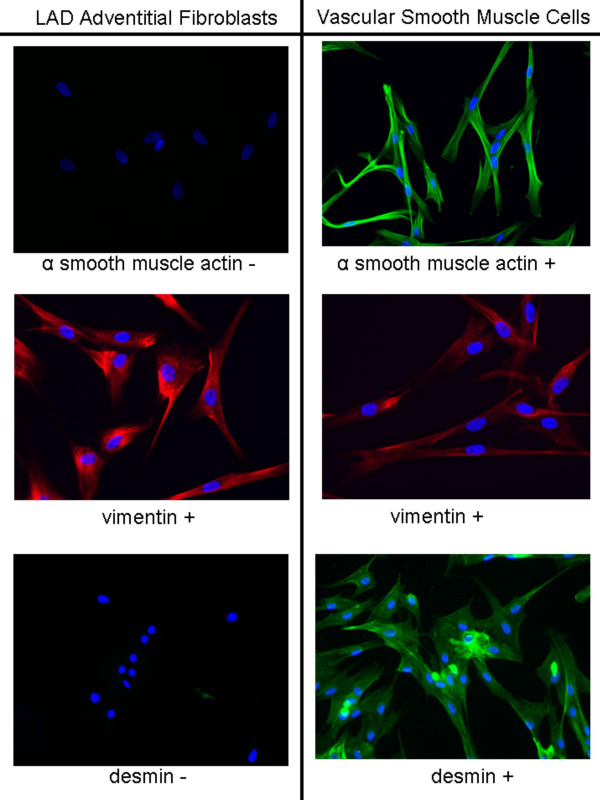
Cell Characterization. Cultured rat coronary artery adventitia fibroblasts (LAD) and aortic vascular smooth cells (VSM) (positive control) stained for desmin, α-smooth muscle actin (α-SMA) and vimentin. LAD stained negative for desmin and αSMA and positive for vimentin, a fibroblast marker. VSM stained positive for all 3 proteins. Desmin and α-SMA are specific VSM markers.